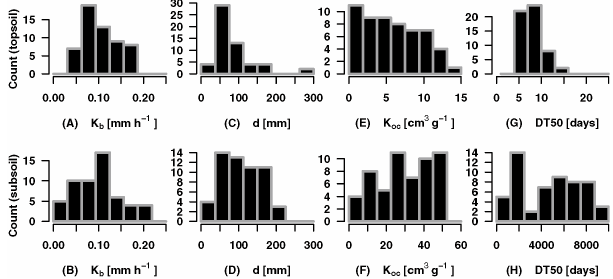
Fig. 3. Histograms with the posterior distributions of the eight dif- ferent parameters included in the calibration step: saturated matrix hydraulic conductivity ( K b ), diffusion path-length ( d ), soil organic carbon partitioning coefficient ( K oc ) and the degradation half-life time (DT50). The range of values on the x axis denote the prior range used for the different parameters. The total number of counts is 56 in all cases.